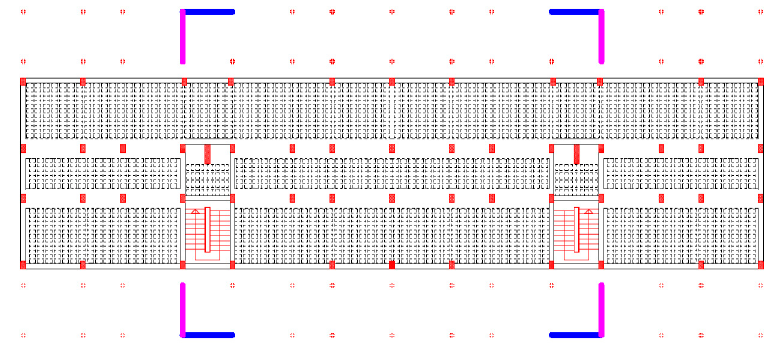
Figure 11. Plan view of the building and position of the dissipative braces (in bold).